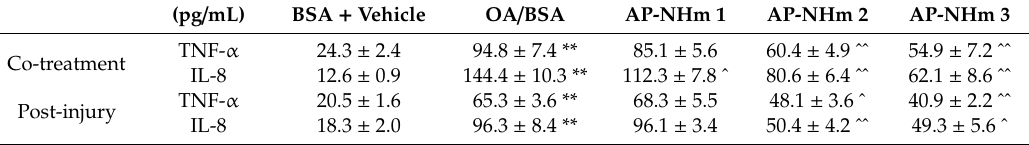
Table 2. E ff ects of OA and AP-NHm mixture on TNF- α and IL-8 concentration (pg / mL) in the cellular medium.